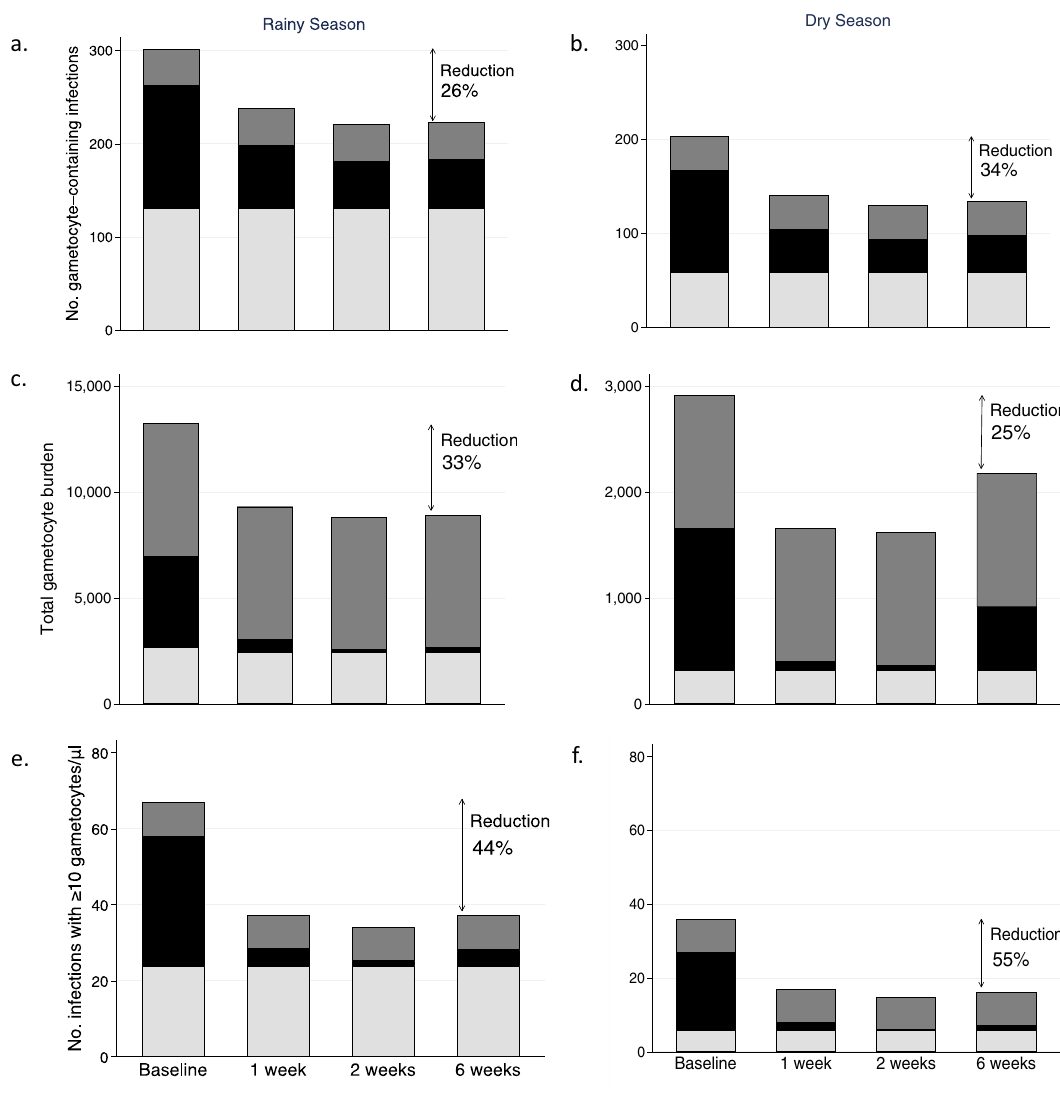
Figure 3. Predicted impact of school-based treatment of RDT positive students on the population of gametocytes in the surrounding community. Following school-based screening-and-treatment at baseline, the estimated impact on gametocyte prevalence (a in rainy and b in dry seasons), total gametocyte burden (c in rainy and d in dry seasons), and number of infections containing ≥ 10 gametocytes/µl (e in rainy and f in dry seasons) in the communities surrounding the schools are predicted at one, two, and six weeks after the intervention. Color indicates the proportion of the gametocyte measure by age group: school-age children (6-15y)—black; younger children (6 m-5y)—light grey; adults (> 15y)—dark grey. Total gametocyte burden is the sum of gametocyte densities in individuals in each age group. These calculations assume treatment is not provided to young children, adults, or school-age children who test negative by RDT when the intervention is implemented. Reduction is calculated as the proportional difference between the baseline and six-weeks post